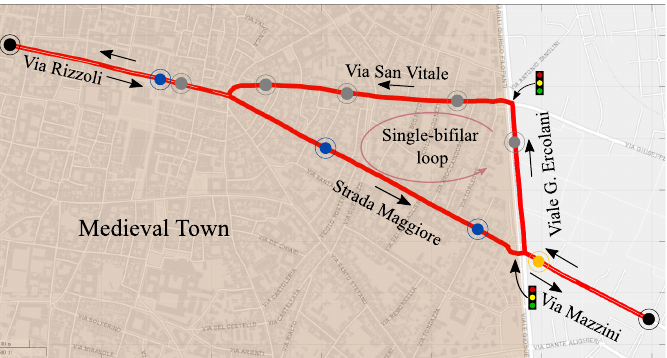
Figure 4. Bus stops of line 15 in FS MTT. Initial and final stops for outward and return journey (black points); intermediate stops for outward journey (blue); intermediate stops for return journey (grey); common stop for outward and return journey (yellow). Arrows indicate the trolleybuses’ travel